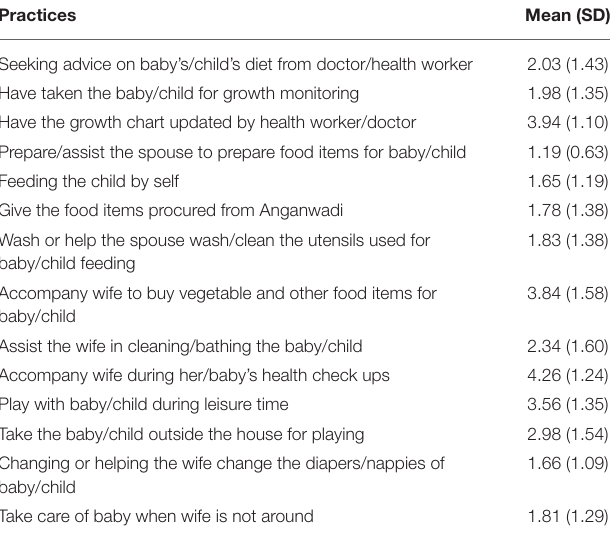
TABLE 5 | Univariate analysis of the sociodemographic correlates of poor involvement in IYCF among study participants ( N = 45).